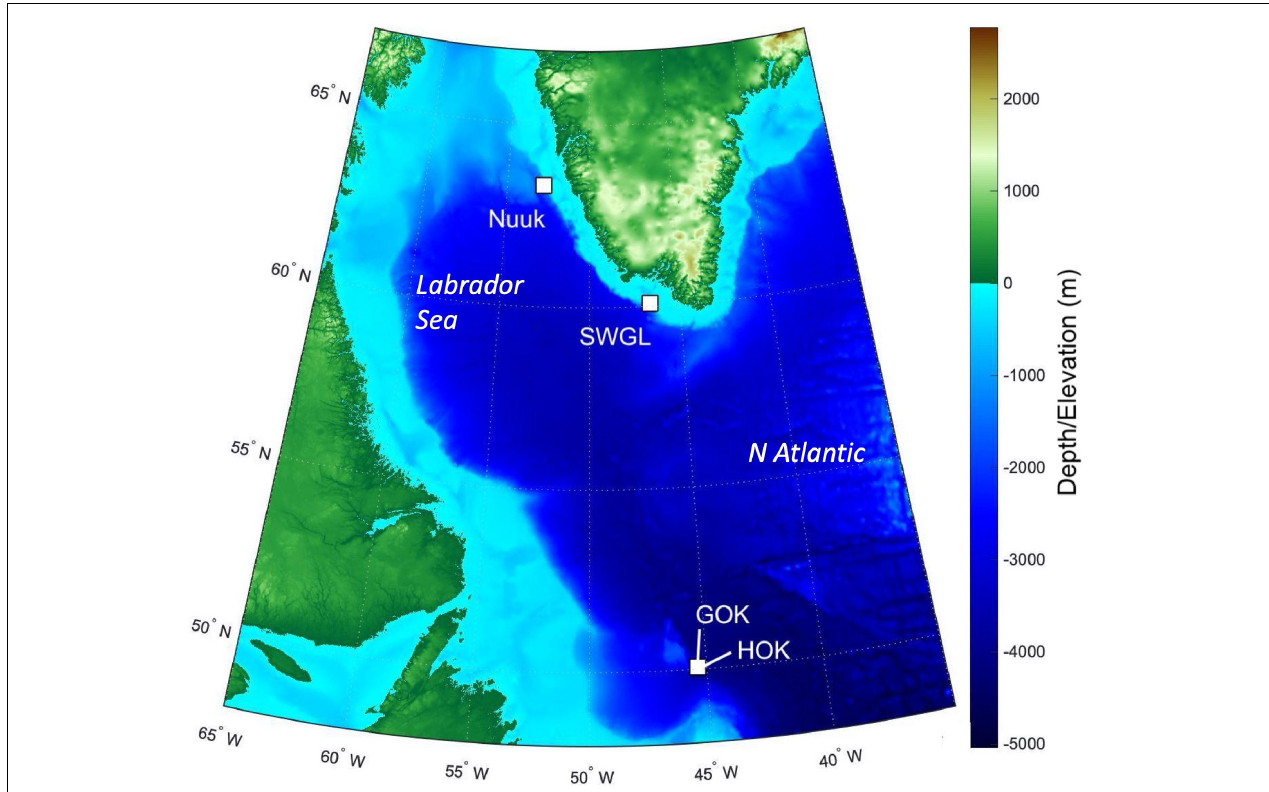
FIGURE 1 | Overview map showing the position and depth of the four localities Nuuk, Southwest Greenland (SWGL), Geodia dominated sponge ground at Orphan Knoll (GOK), and hexactinellid dominated sponge ground at Orphan Knoll (HOK) from the DY081 Cruise in the Labrador Sea. Bathymetry used is from ETOPO1 model from https://www.ngdc.noaa.gov/mgg/global/.